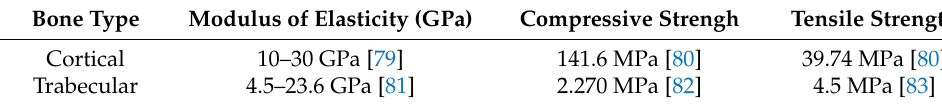
Table 5. Young’s Modulus of both Cortical and Cancellous (Trabecular) bone.